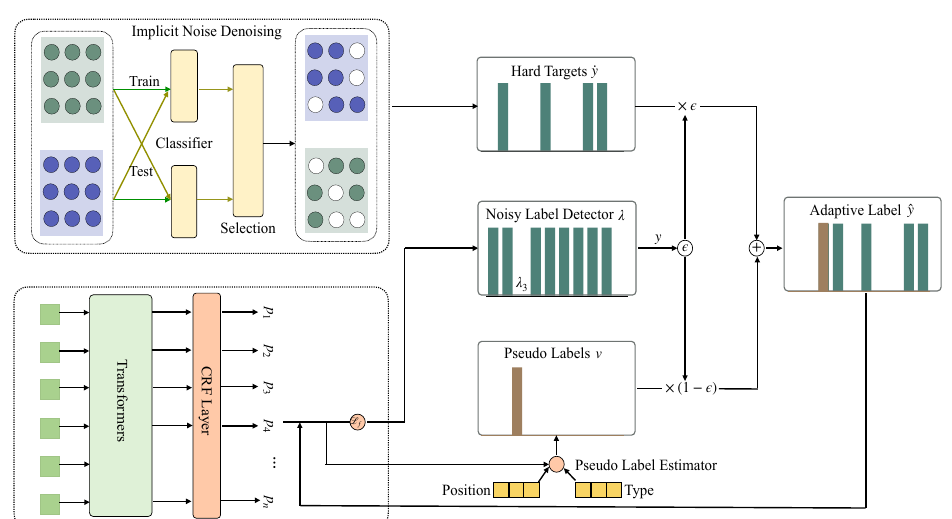
Figure 2. An overview of the proposed SALO. The model is iteratively fine-tuned for several steps. In each step, an Implicit Doise Denoising module is trained on the noisy data in a K-fold (k = 2 in the figure) cross-valid fashion to alleviate over-fitting to noisy labels; afterwards, a noisy label detector and a pseudolabel estimator are introduced for noise detecting and explicit noise correction, respectively. While the iteration continues, the noisy labels are steadily identified and corrected, thus benefiting the optimization of the NER